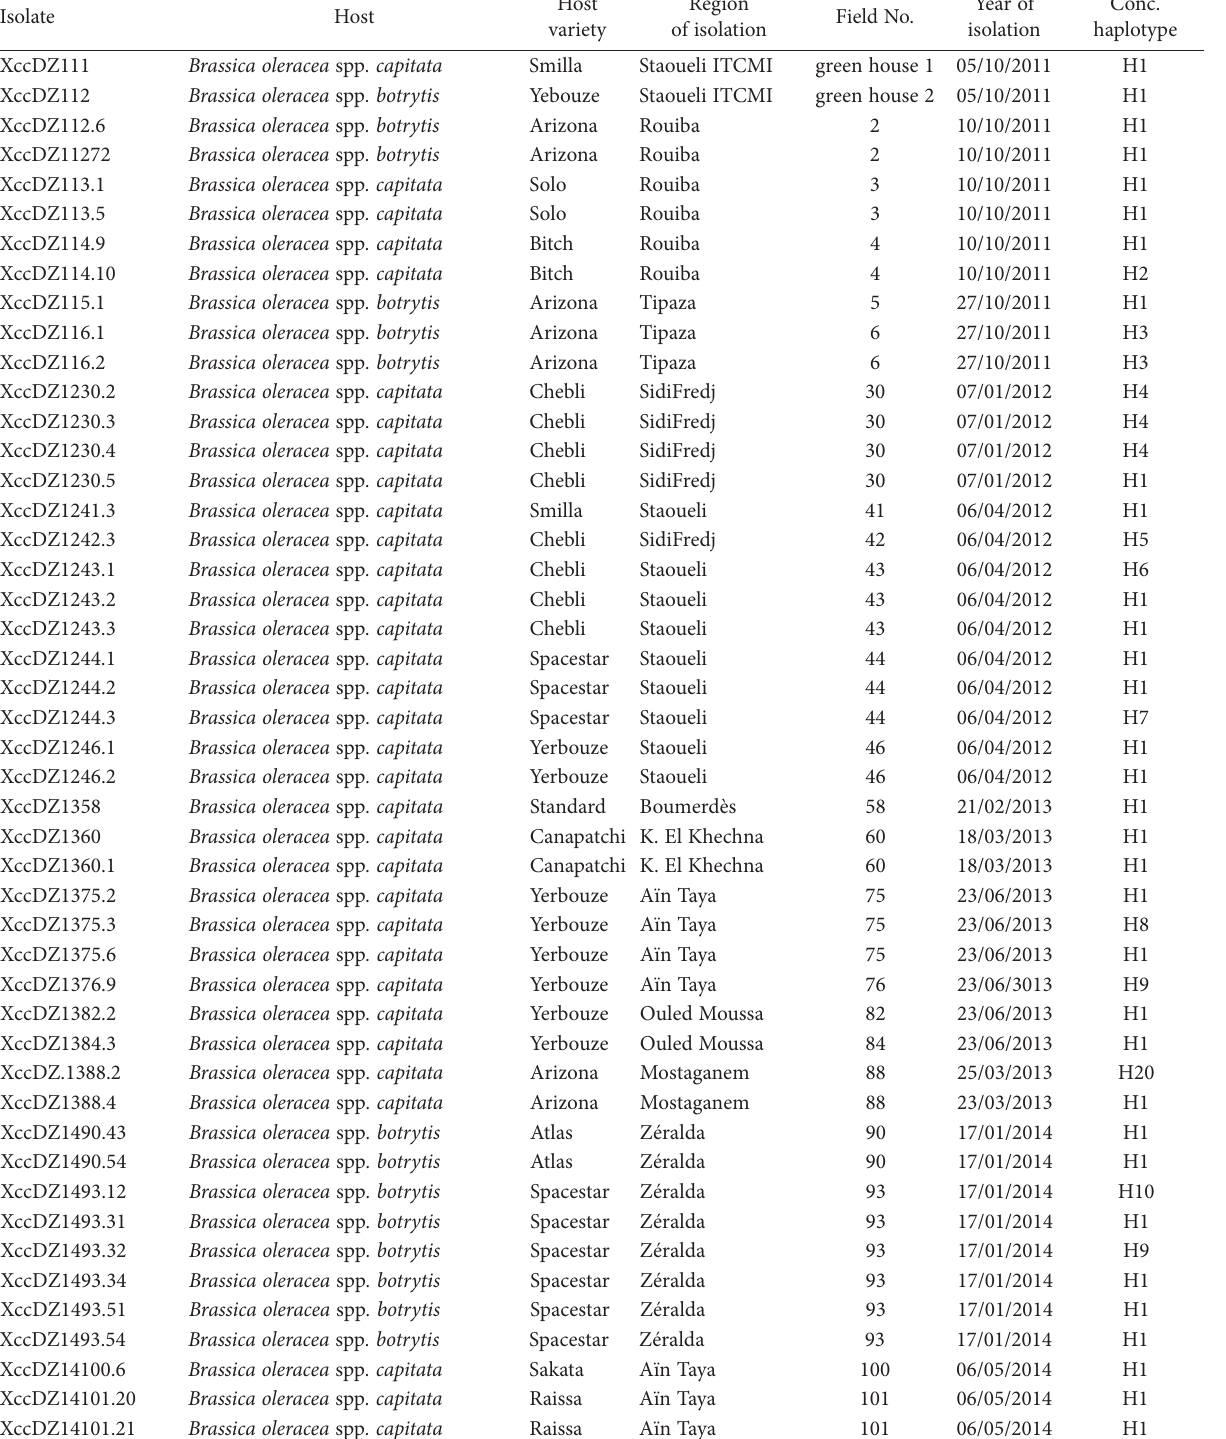
Table 1. Xanthomonas campestris pv . campestris isolate designations, their hosts, source regions, and haplotypes formed with concatenated partial sequences, for 77 isolates ontained in